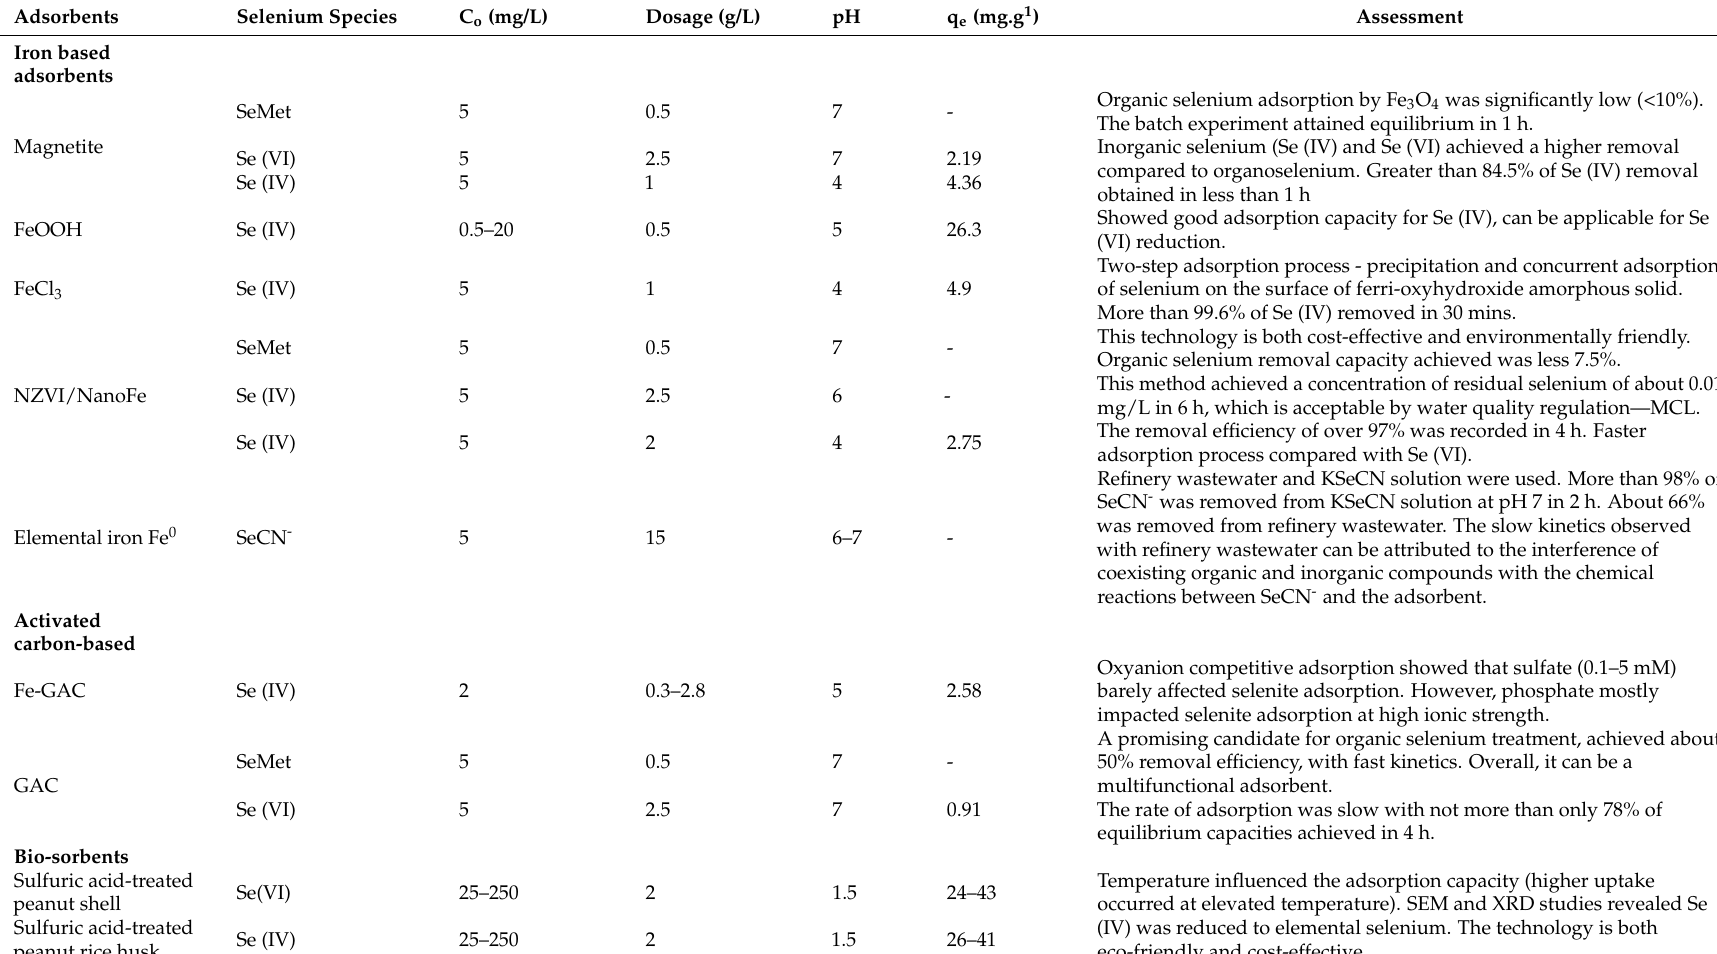
Table 1. Selected adsorption techniques used for the removal of organic and inorganic